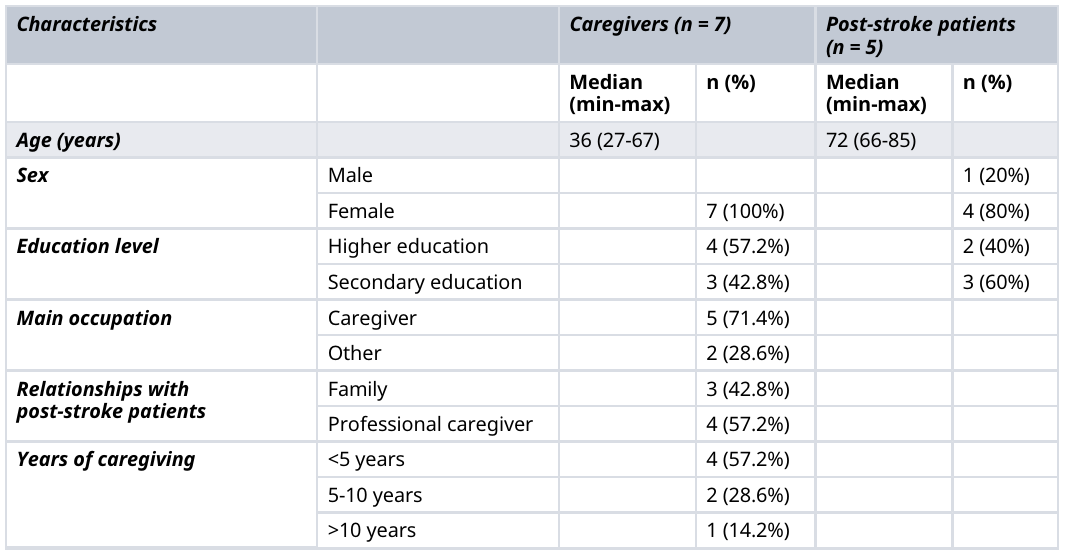
Table 1. Characteristics of participants and post-stroke